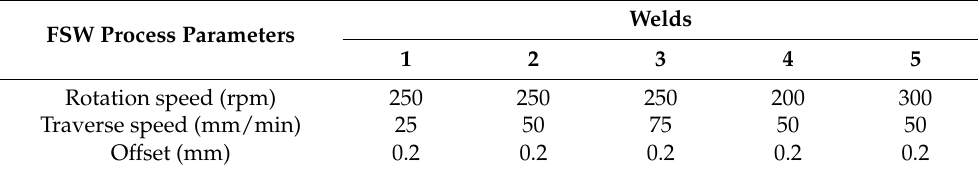
Table 3. FSW parameters of the friction stir welding applied for the aluminum–steel welds under investigation.